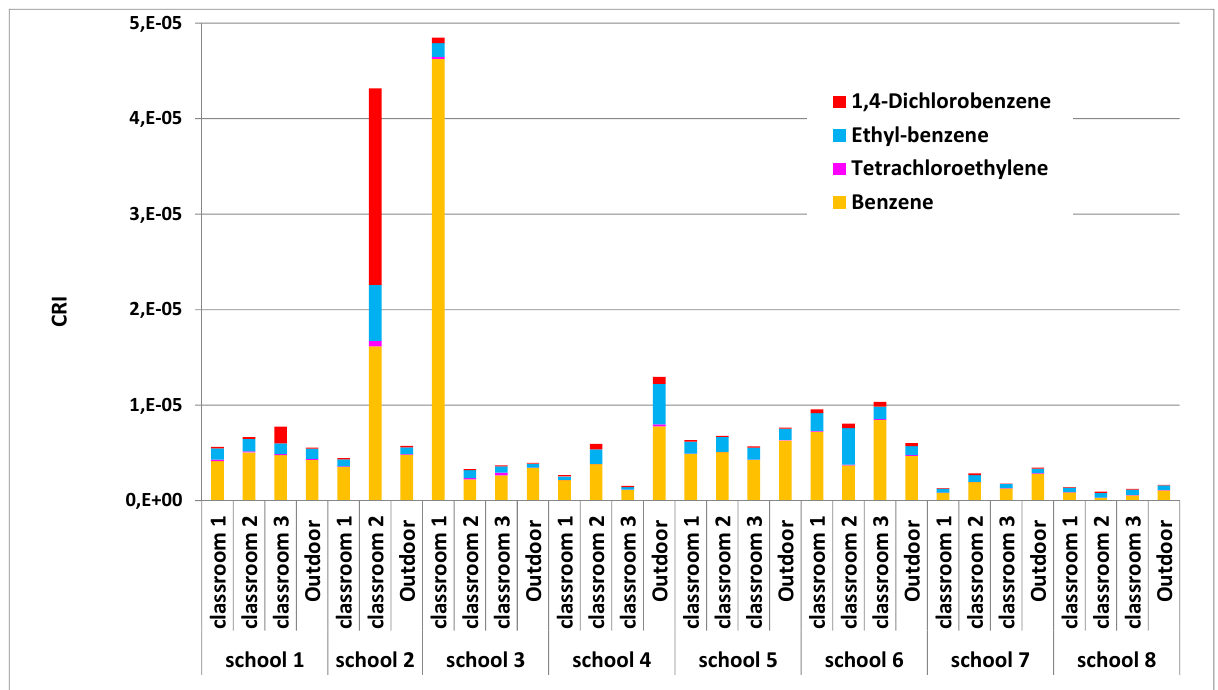
Figure 6. Cancer Risk Indicator in each monitored site.